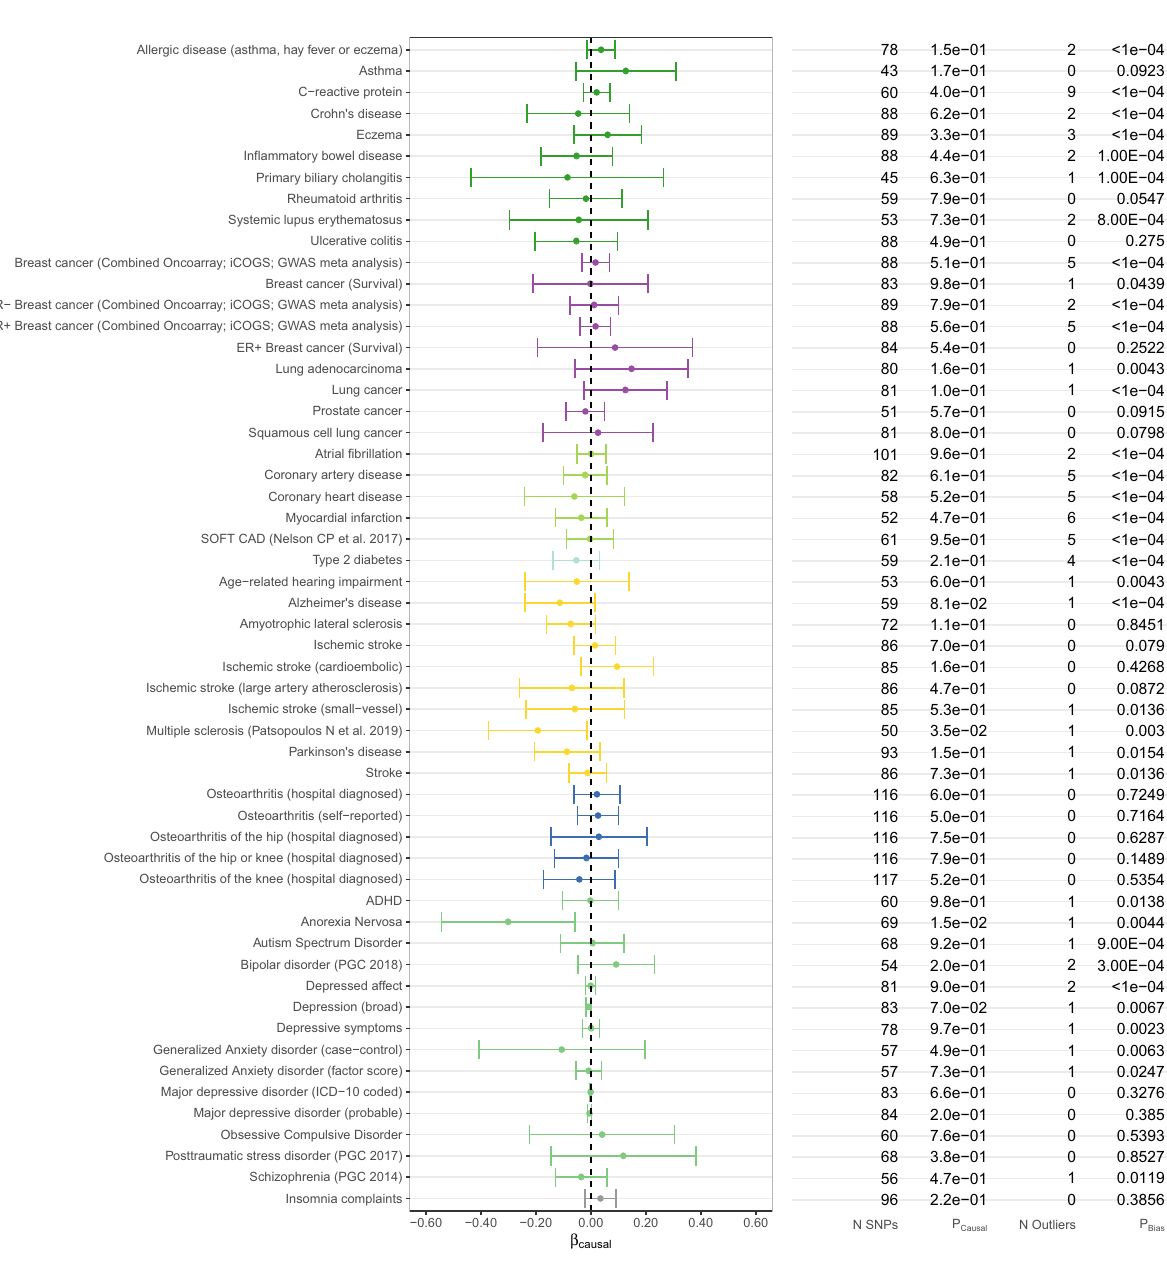
Figure 1. Estimated causal effects of 25(OH)D on complex diseases based on the MR-PRESSO approach using 138 genome-wide significant, conditionally independent SNPs of 25(OH)D. The β causal corresponds to 1 standard deviation increase in log-transformed vitamin